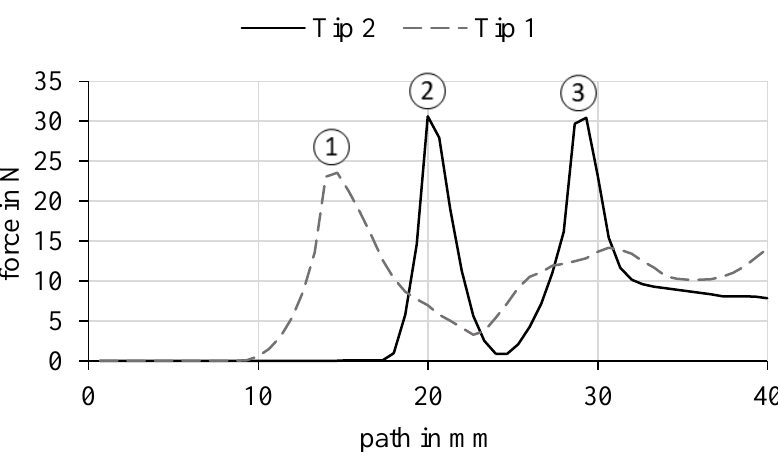
Figure 4. Typical measurement curve of the two load cells of the tactile